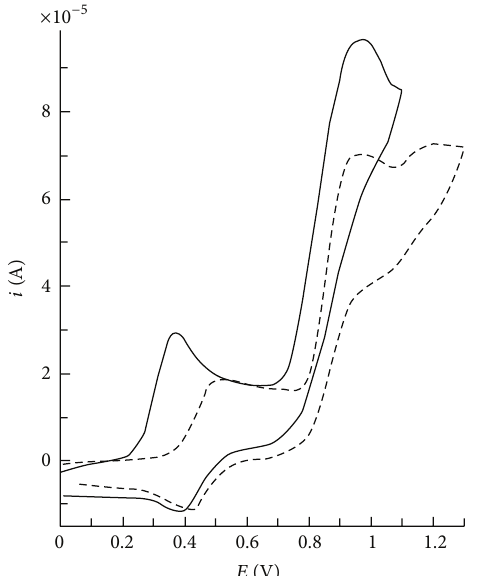
Figure 5: CV of 2.0 mM of chemosensor 1 in absence (—) and in presence of 1.0 equivalent Cd 2+ (2.0mM) (– – –) recorded in DMF containing 0.1M TBABF 4 . Working electrode: glassy carbon; reference electrode: SCE (KCl 3 M); scan rate: 0.1Vs −1